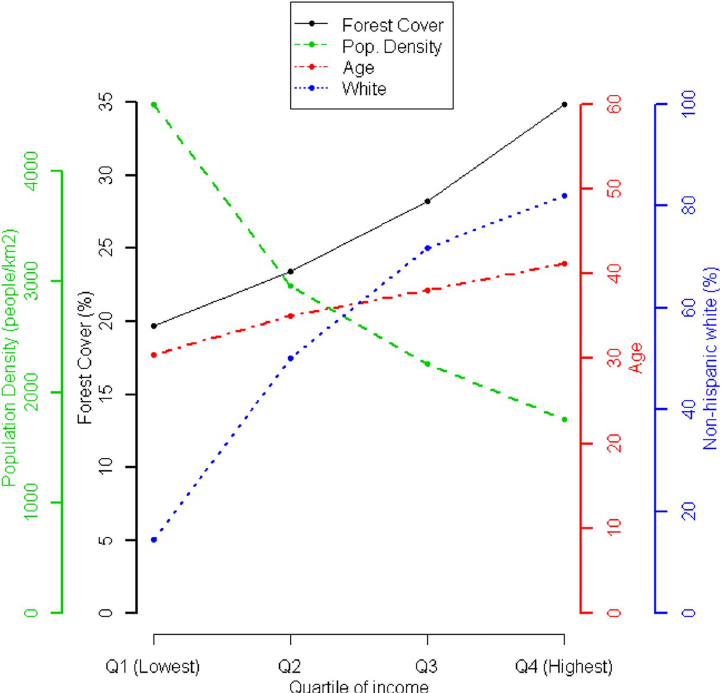
Fig 4. Patterns across blocks of different incomes. Census blocks within each urbanized area were classified by the quartile of income they occupy. For each quartile, we show the median tree cover, population density, age, and percent non-Hispanic